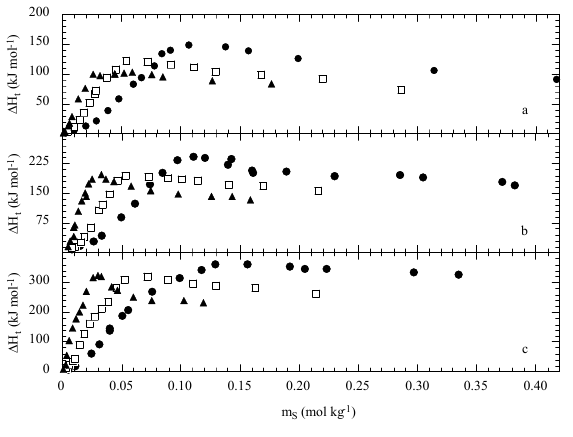
Figure 9. Enthalpy of transfer of copolymer from water to the aqueous sodium decanoate